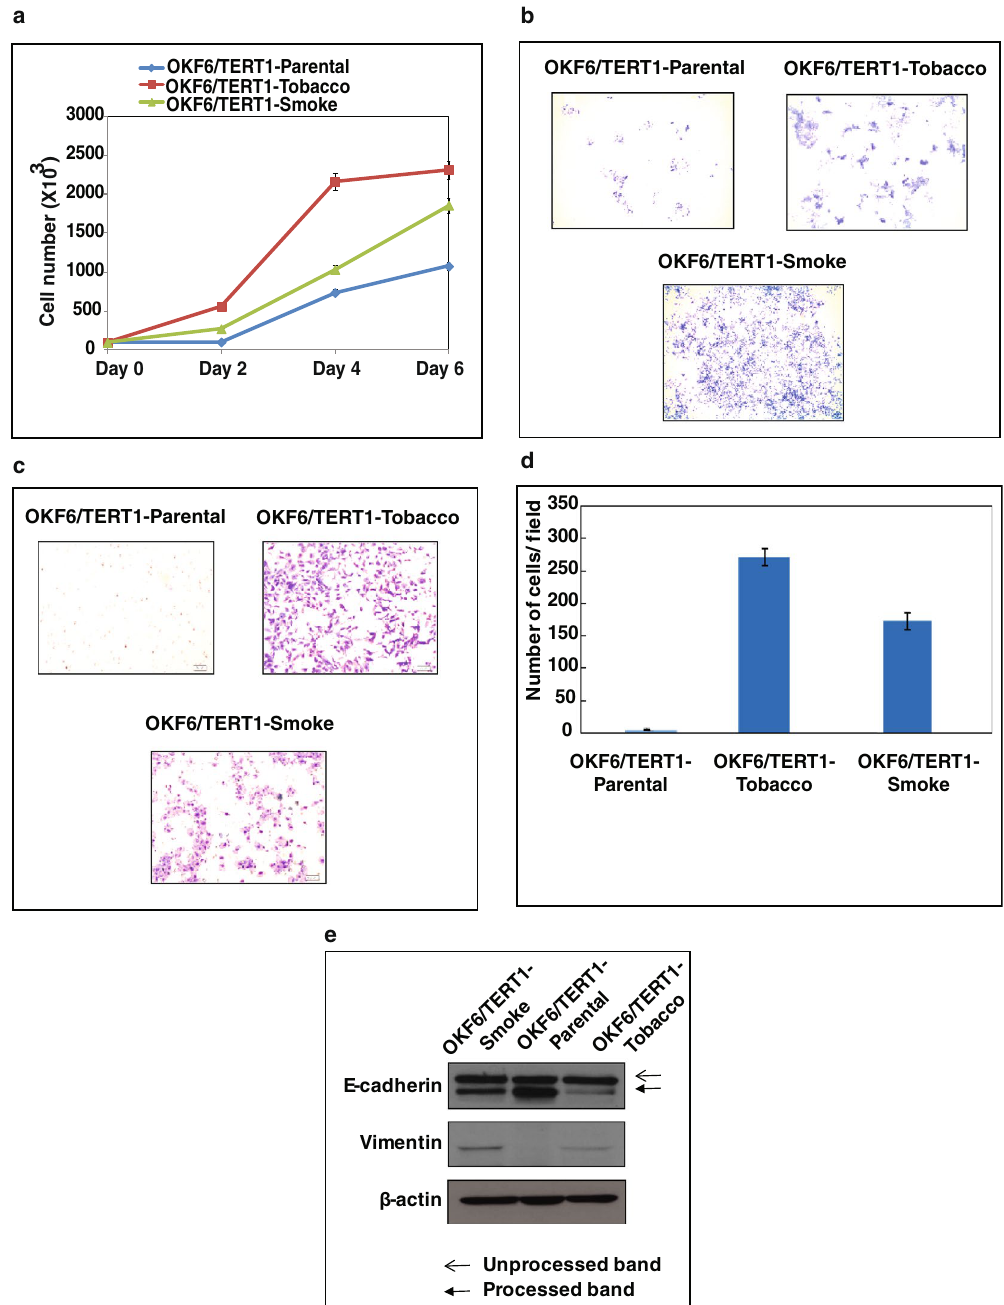
Figure 1. Chronic treatment of oral keratinocytes with chewing tobacco and cigarette smoke. OKF6/TERT1- Parental, OKF6/TERT1-Tobacco and OKF6/TERT1-Smoke cells were assessed for ( a ) cellular proliferation ( b ) colony formation ( c , d ) invasive ability and ( e ) epithelial–mesenchymal transition (EMT) using Western blotting. β -actin was used as a loading